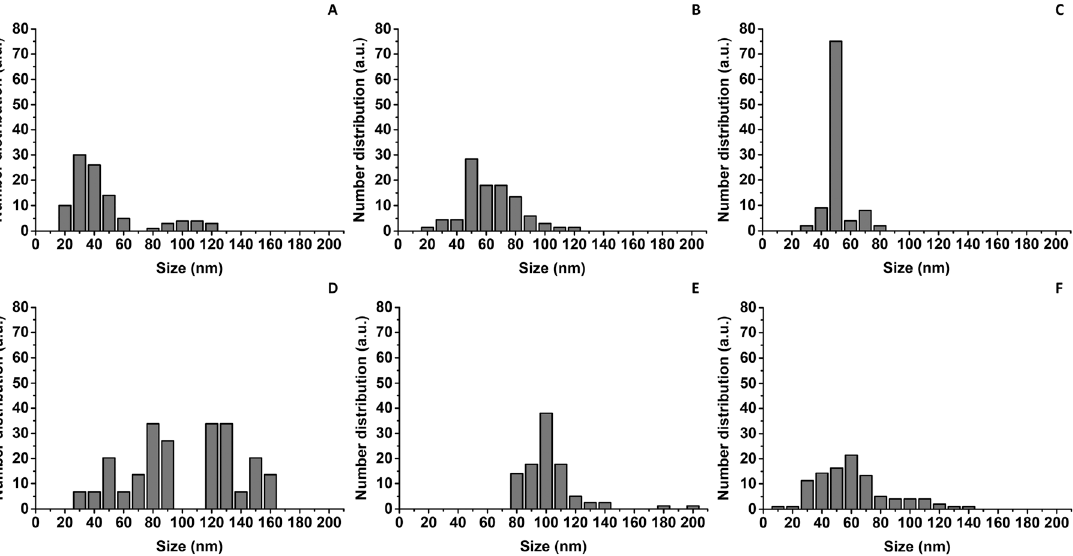
Figure3: SizedistributionofSeNPswithin(A)BioSeNPextract_LB,(B) L -cysSeNPs_1:3(C) L -cysSeNPs_1:3 + OM_LB,(D)BioSeNPextract_NB (E) L -cys SeNPs_1:4, and (F) L -cys SeNPs_1:4 +